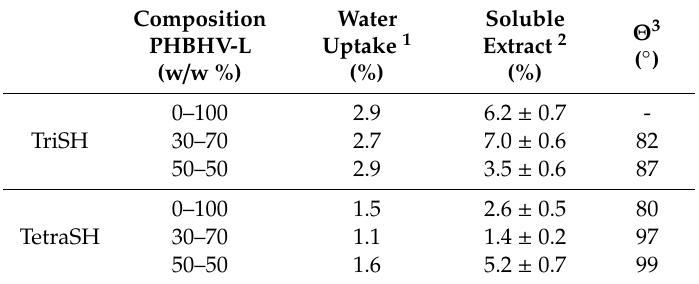
Table 3. Characteristics of the PHBHV-L co-networks.